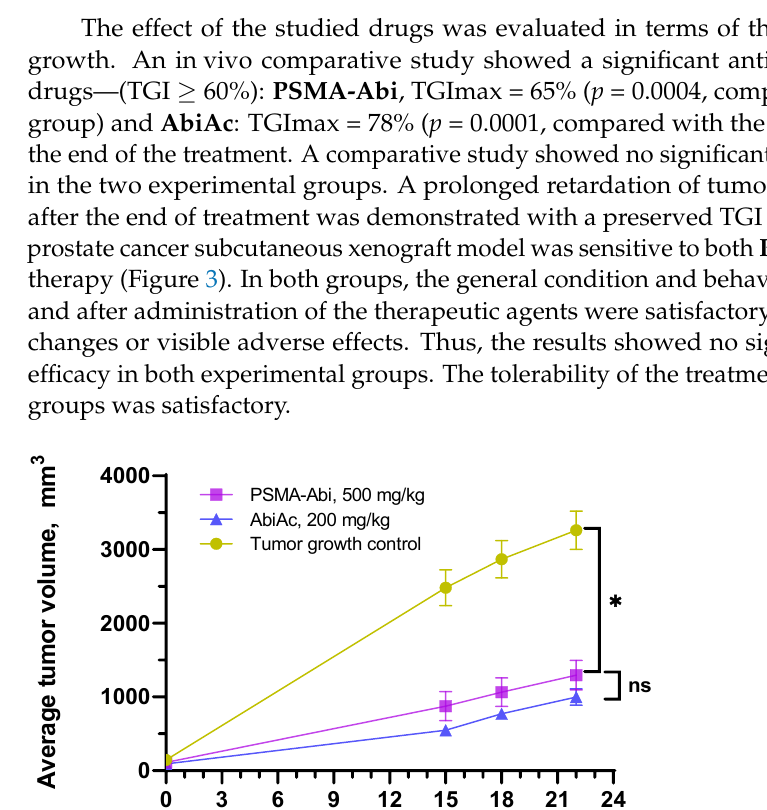
Figure 2. Body weight dynamics of mice after single-dose oral administration of PSMA-Abi (2000 mg/kg).